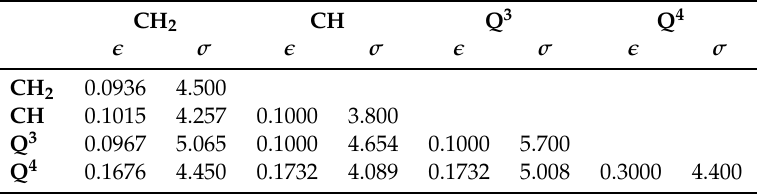
Table 1. Non-bonded parameters for silica obtained from the Boltzmann inversion. Units for (cid:101) and σ are kcal/mol and Å respectively.